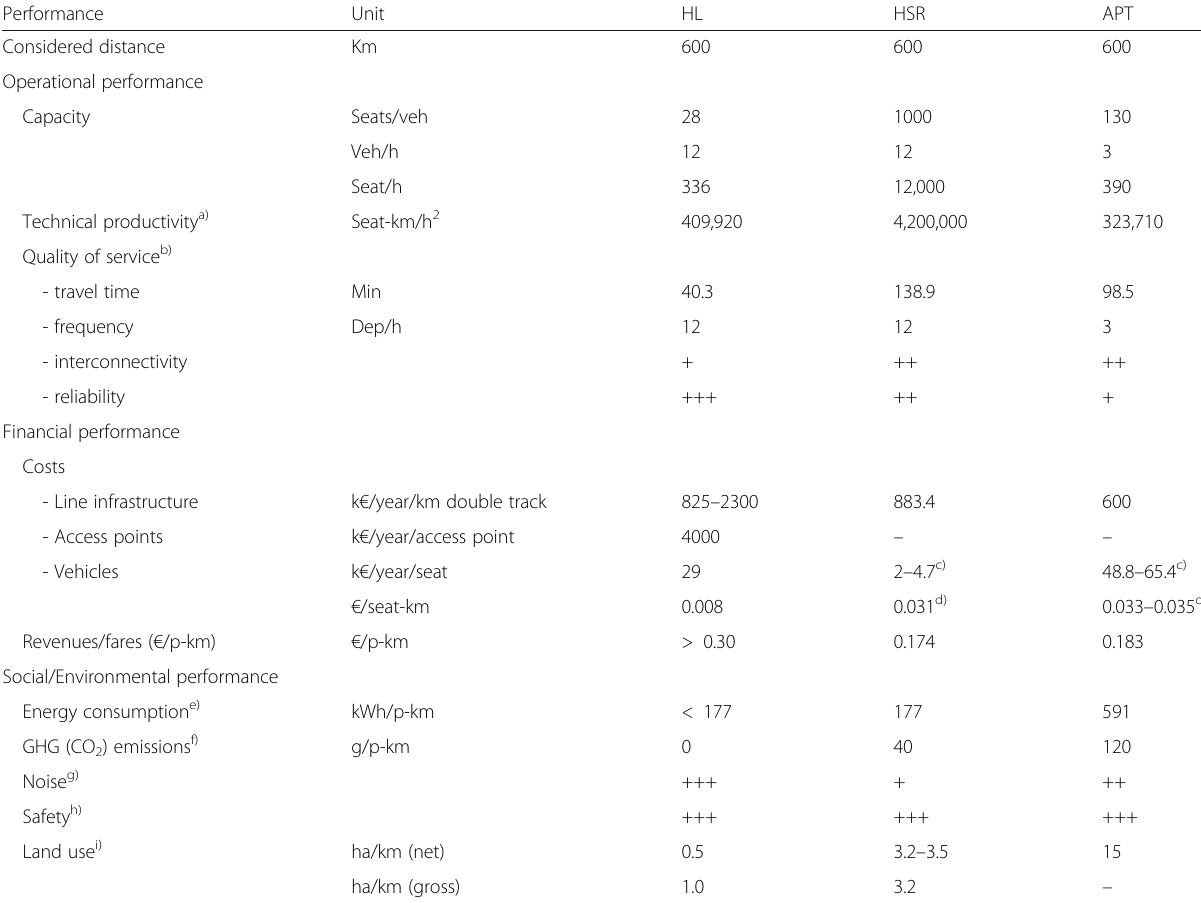
Table 5 Indicators of performances of the HL system and its APT and HSR